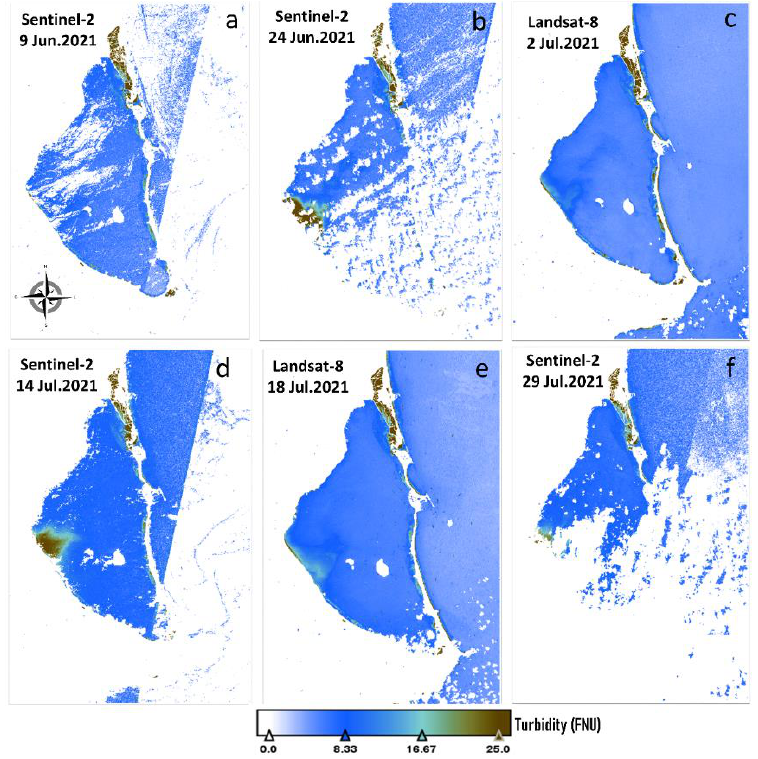
Figure 10. Turbidity (FNU) from Sentinel-2 and Landsat-8 acquired on ( a ) 9 June 2021, ( b ) 24 June